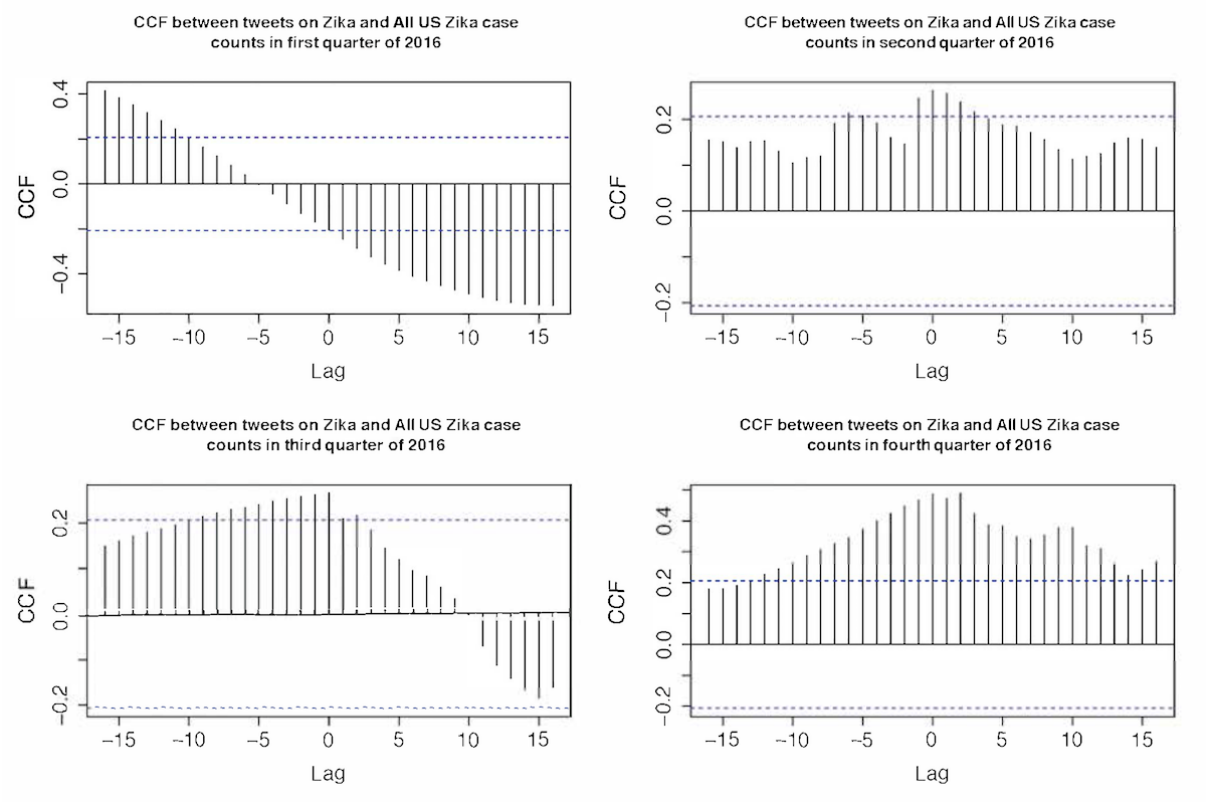
Figure 3. Cross-correlation function between Zika case counts in the domestic United States plus overseas territories and tweet counts in 2016. CCF: cross-correlation